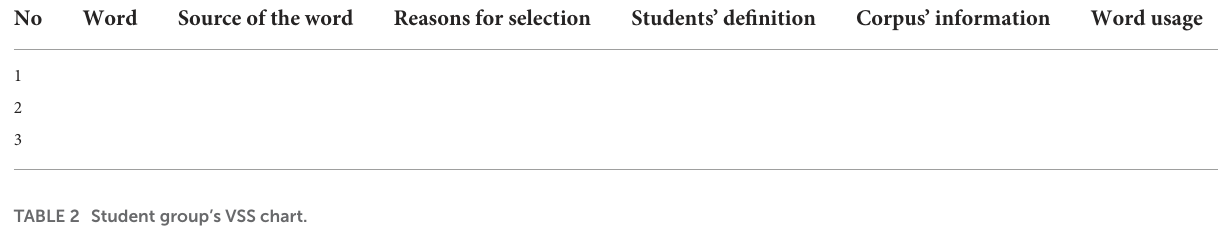
TABLE 1 VSS chart sample.